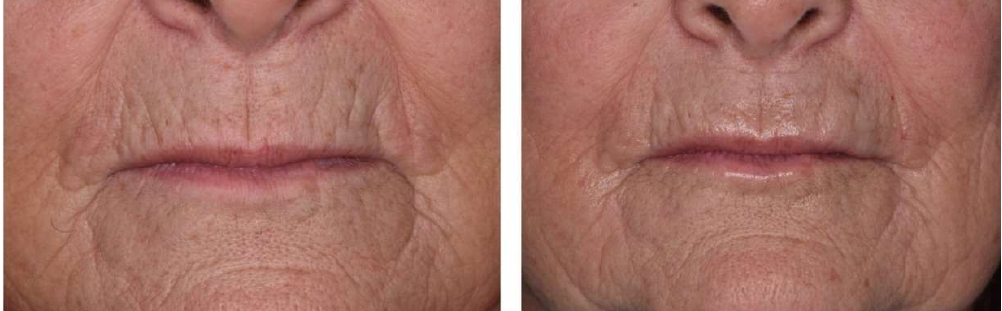
Figure 8. Front view before and after injection of a patient with asymmetry and eversion of the upper lip. The solution considered with the patient consisted of injecting hyaluronic acid, in unequal quantities, into the upper right and left lips.